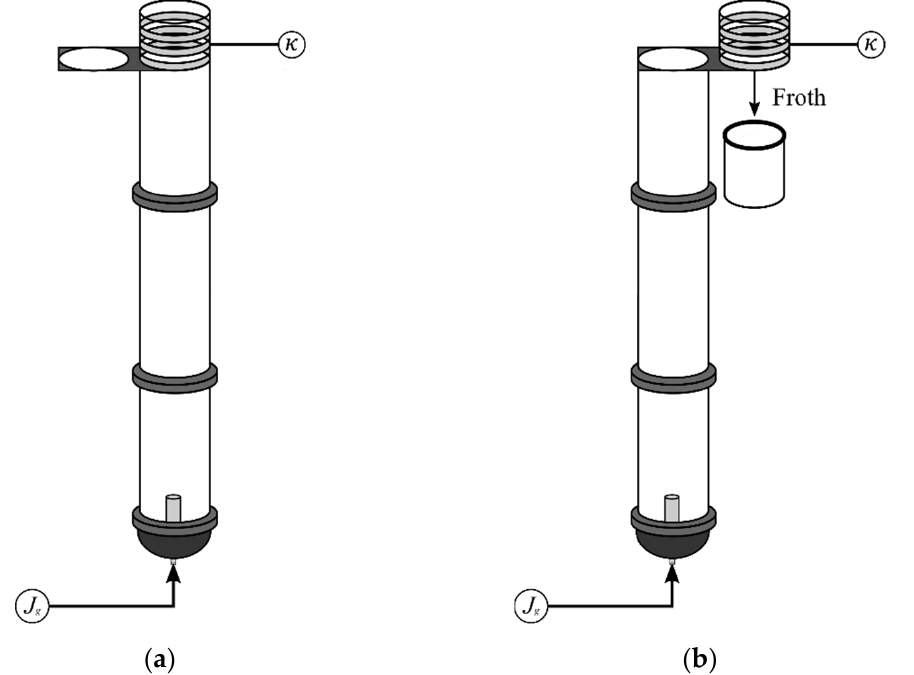
Figure 2. Schematic of the apparatus used to validate the relationship of froth zone water content and relative conductivity. The conductivity cell was placed on a blast gate which could be positioned to measure the froth’s relative conductivity ( a ) and to measure the froth water content ( b ).